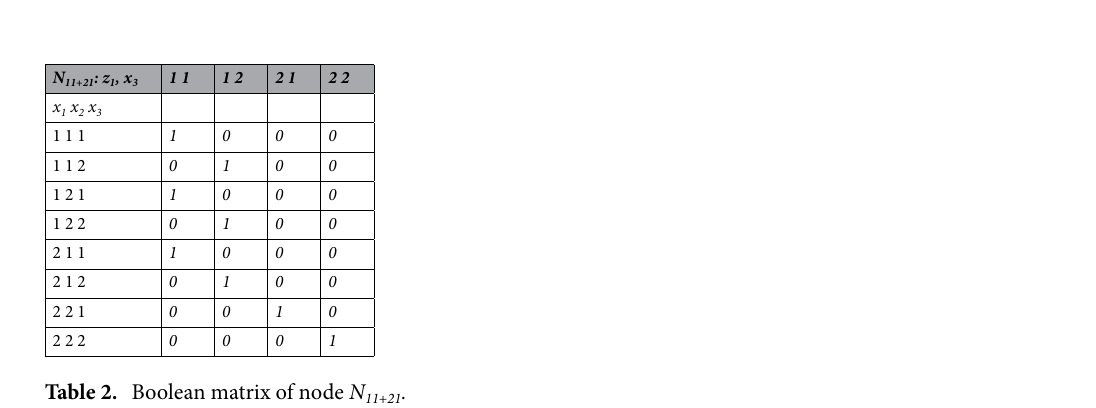
Figure 3. Block-scheme of two nodes’ vertical merging into one node with 3 inputs and 2 outputs.